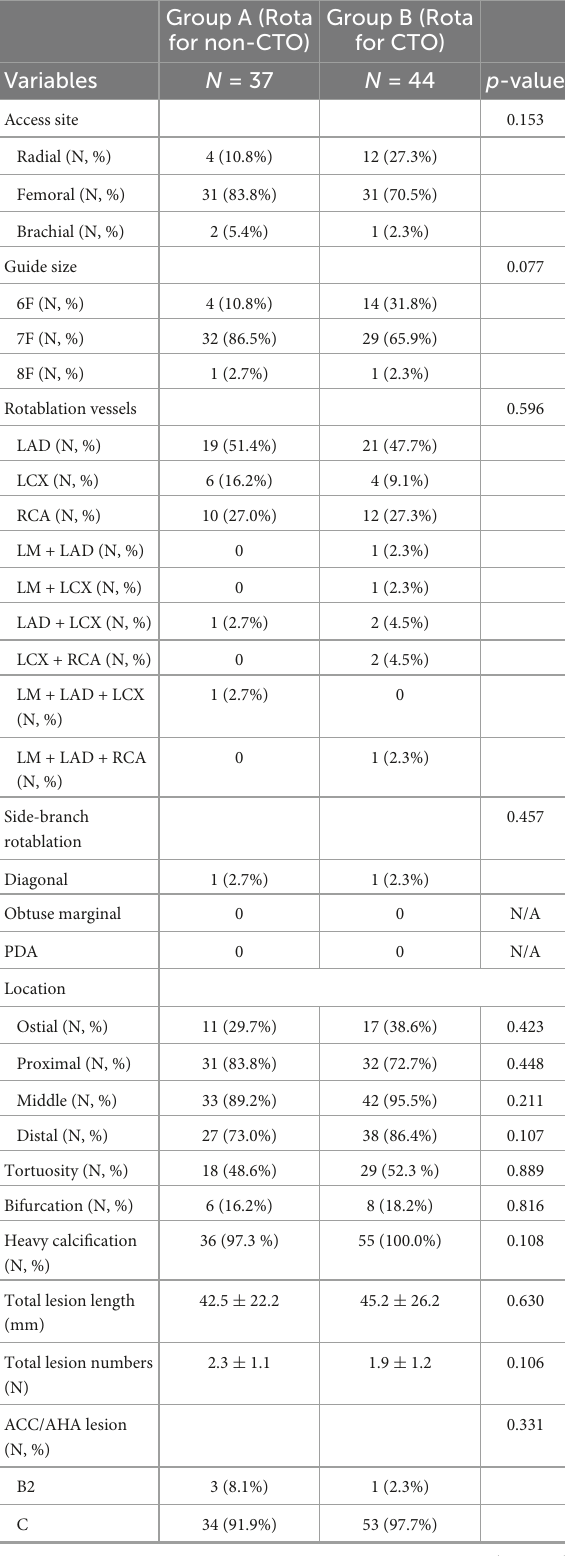
TABLE 2 Lesion characteristics and procedure details in patients treated with rotablation for CTO and non-CTO lesions. Group A (Rota Group B (Rota for non-CTO) for